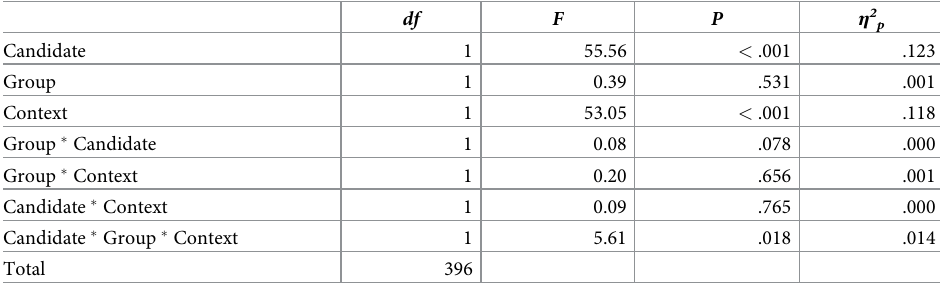
Table 2. Analysis of variance on judgments by group, candidate and context in Experiment